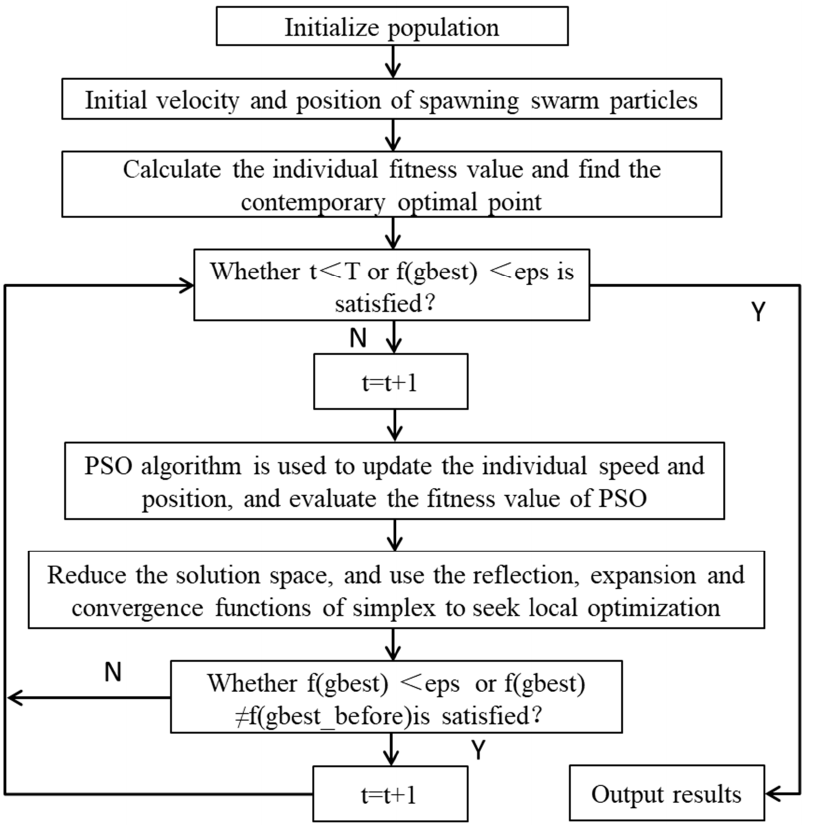
Figure 3. Flow chart of NM-PSO algorithm.